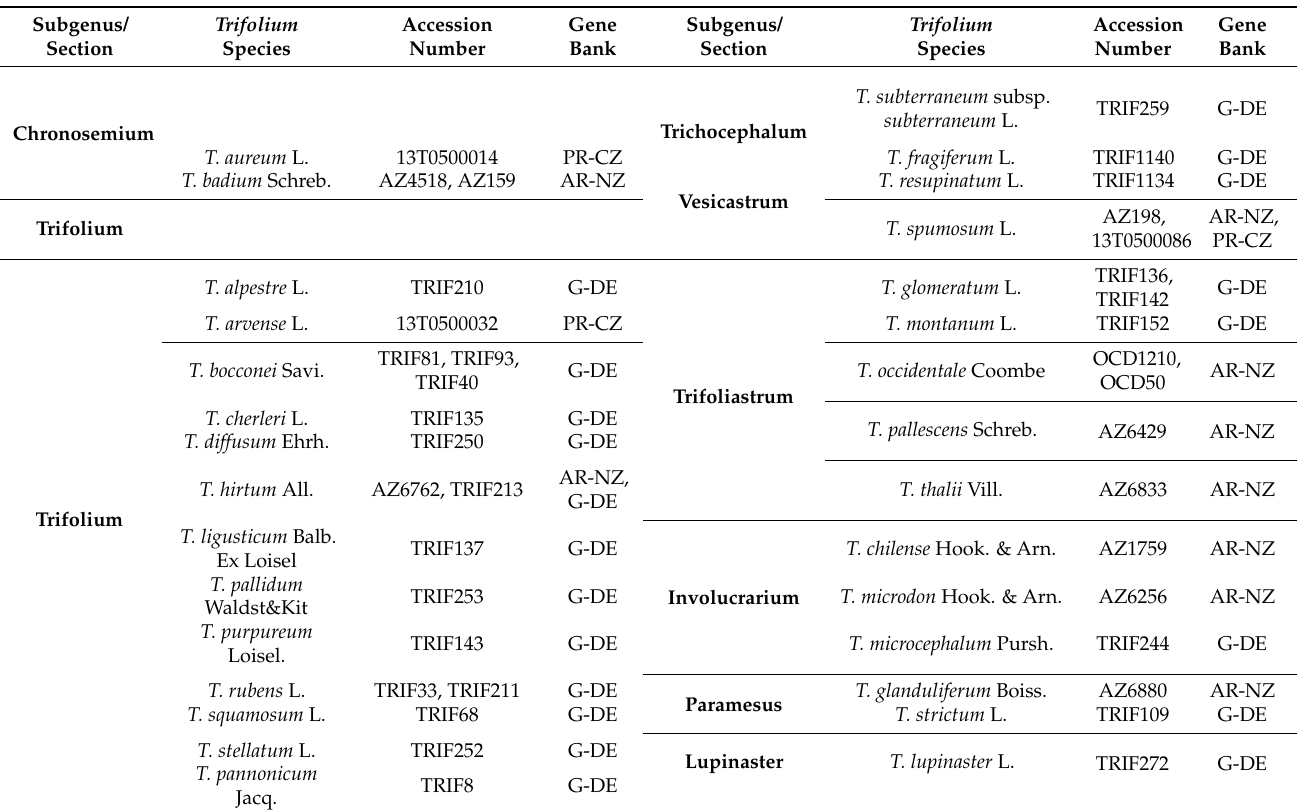
Table 2. Origin and accession numbers of analysed Trifolium